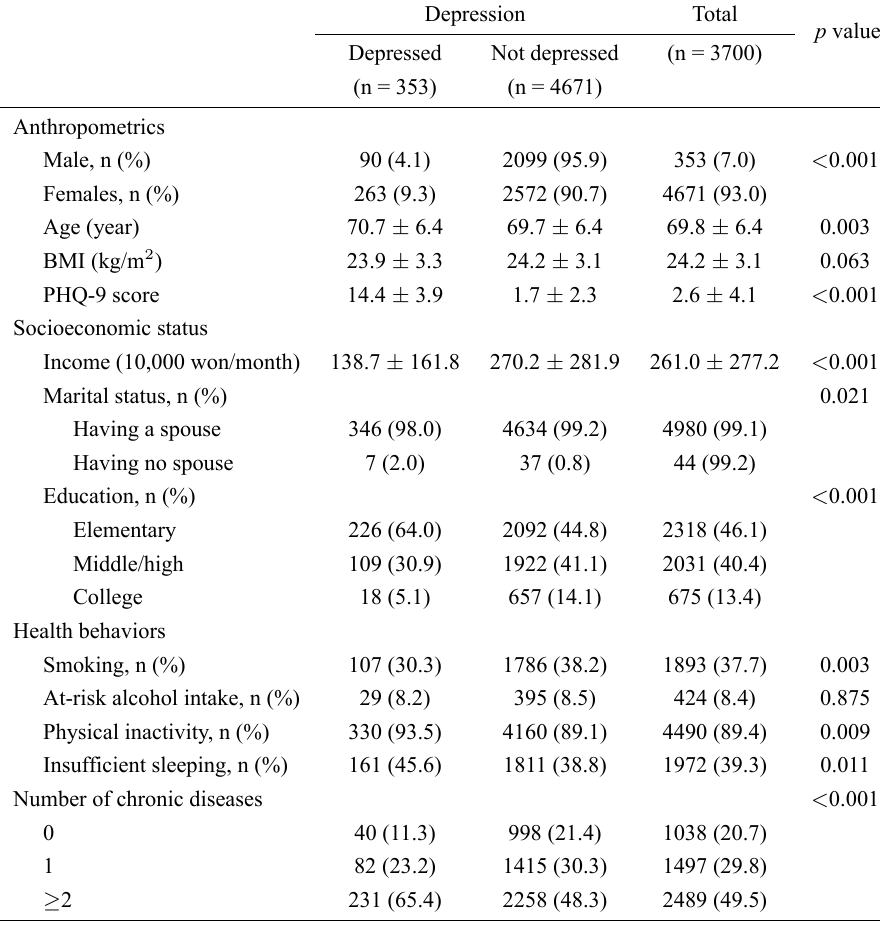
Table 2. Description of study participants by the presence of depression.